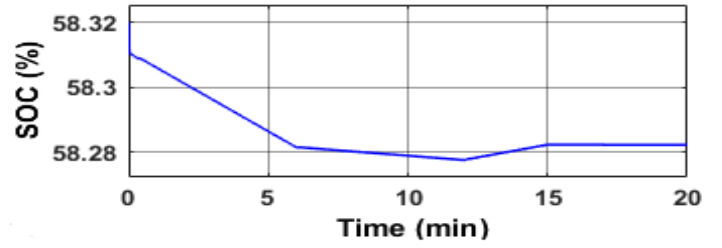
Figure 19. Battery charging and discharging.